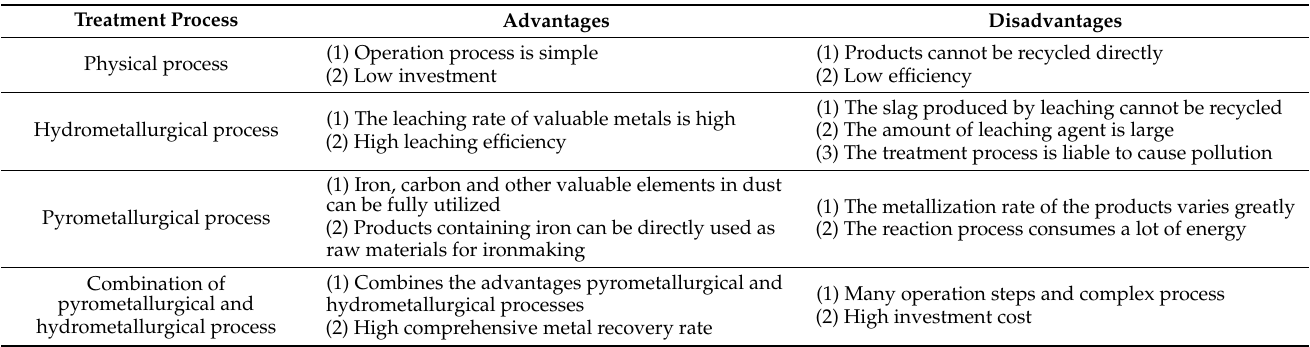
Table 4. Comparison of several treatment processes of extracting metals from steel dust [16,22,46]. Treatment Process Advantages